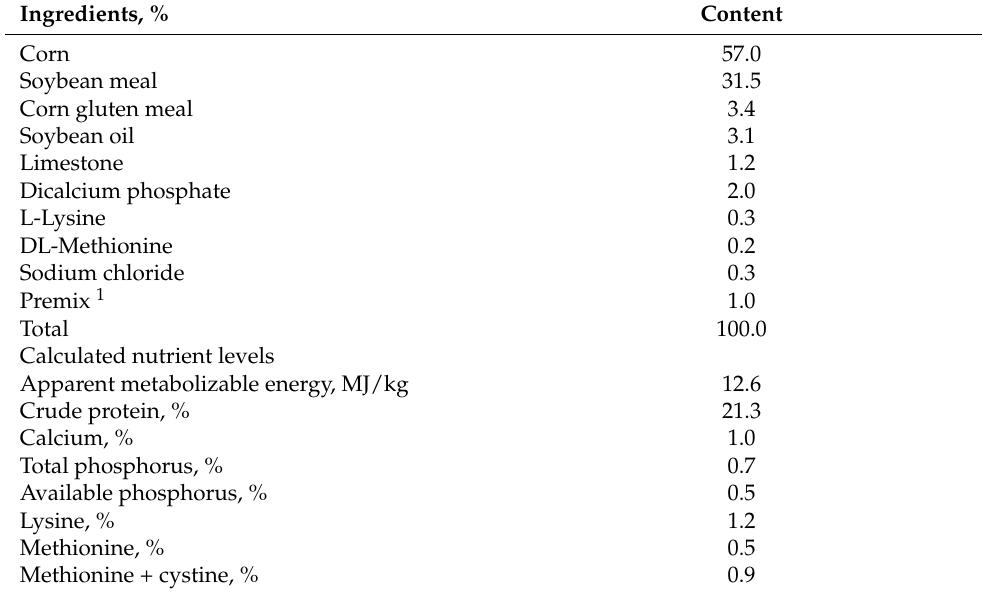
Table 1. Composition and nutrient level of basal